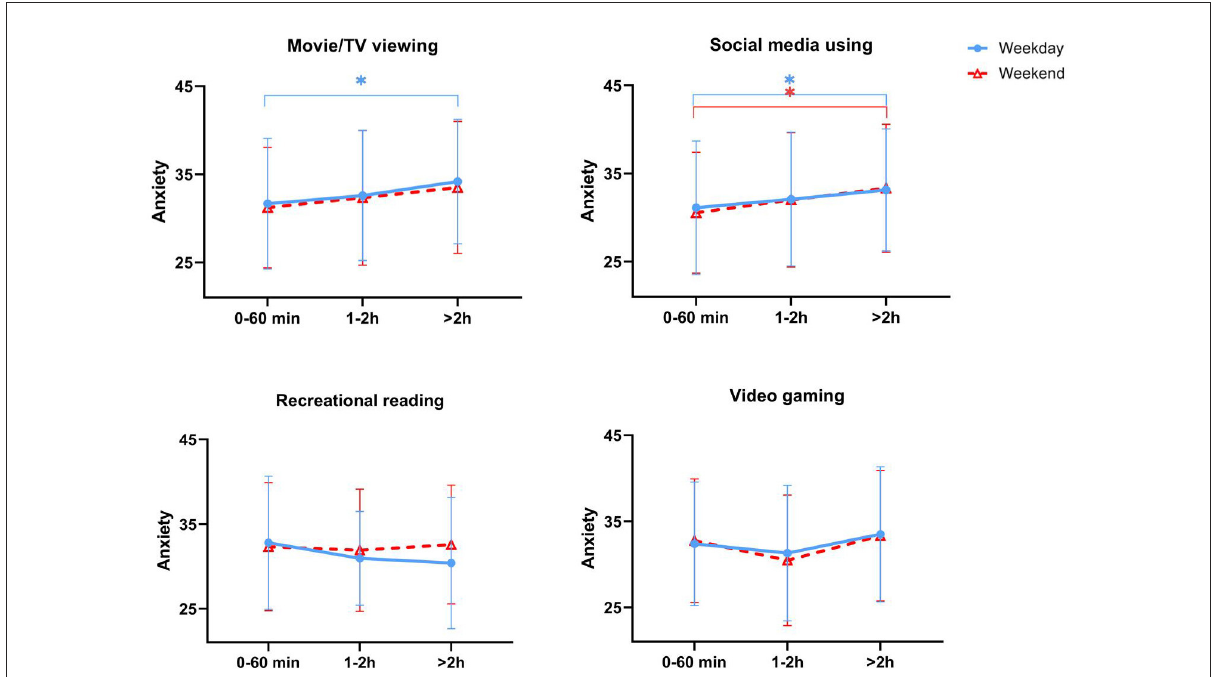
FIGURE1 Trends of anxiety scores with time spent on different screen-based sedentary behaviors. Data are expressed as mean and standard deviation. * indicates p < 0.05 compared to